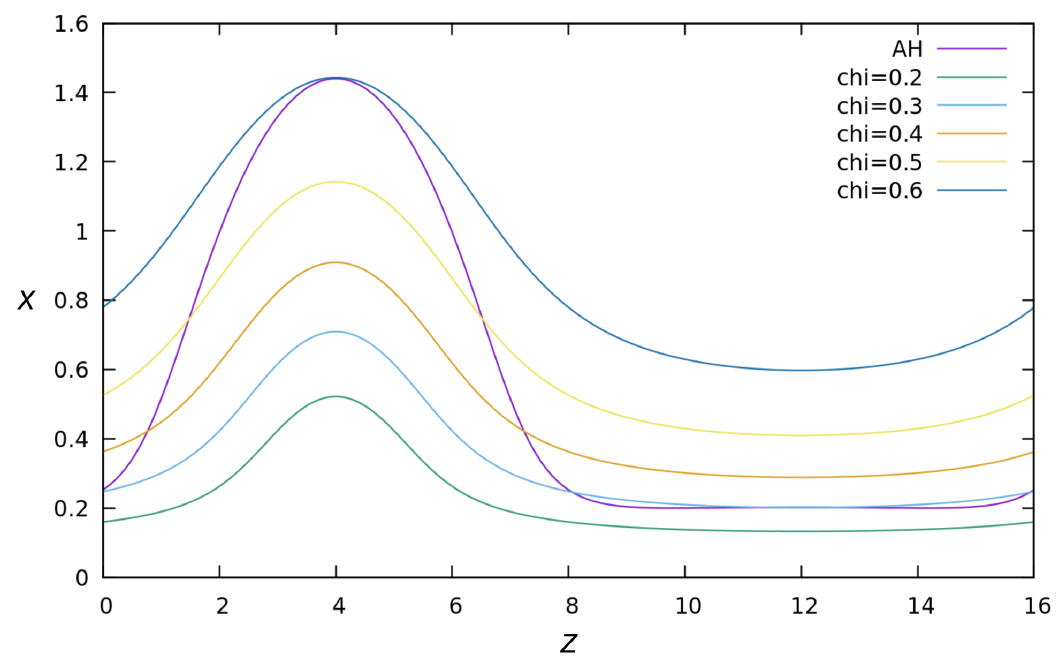
Figure 3 . AH and several χ contours during the evolution of the GL instability of a black string in 5 D . Here X and Z are the coordinates of the computational domain for a black string with a four-dimensional mass parameter M = 1 and a Kaluza-Klein circle with asymptotic length L = 16